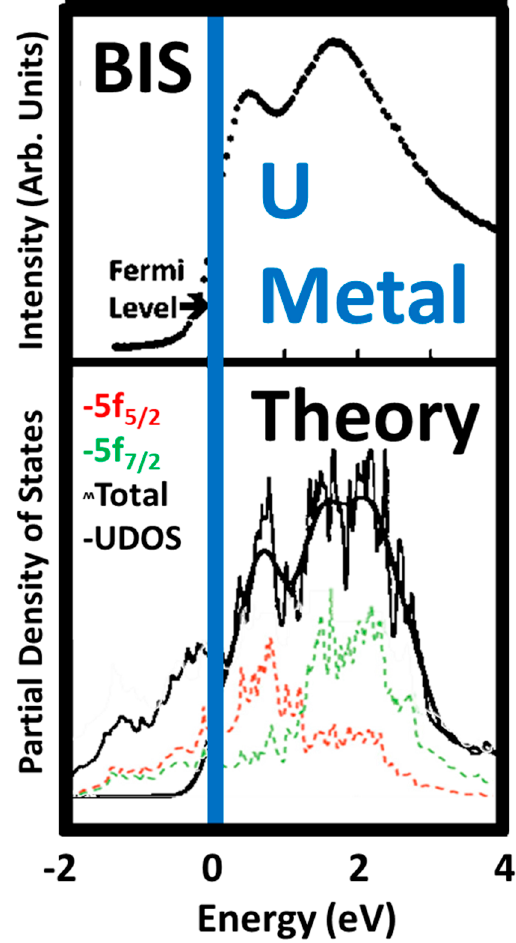
Figure 3. Comparison of the Bremstrahlung Isochromat Spectroscopy (BIS) results of Baer and Lang [18] with the Unoccupied density of states (UDOS) derived from the theory by Kutepov [10]. In the lower panel, the unsmoothed 5f 5/2 calculation is shown in red, the unsmoothed 5f 7/2 calculation is shown in green, the partially smoothed total is the jagged black line and the UDOS is shown by the very smooth, heavier black line. The UDOS was derived by applying an inverse Fermi function and more extensive smoothing to the total.